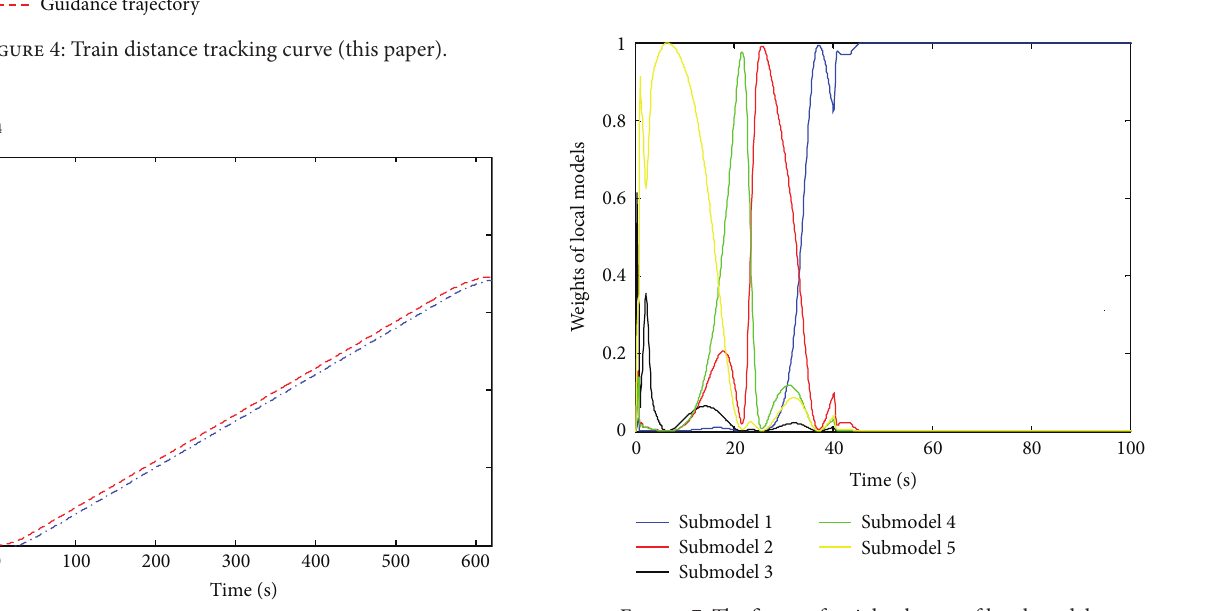
Figure 7: The figure of weight change of local